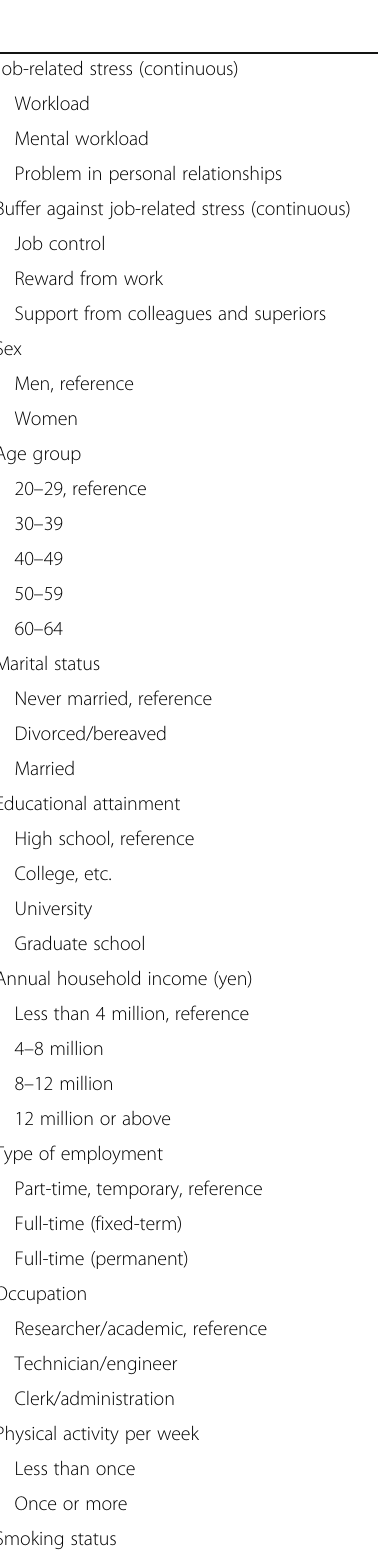
Table 3 Binomial logistic regression analysis related to flourishing mental health ( n = 7012), Tsukuba, Japan